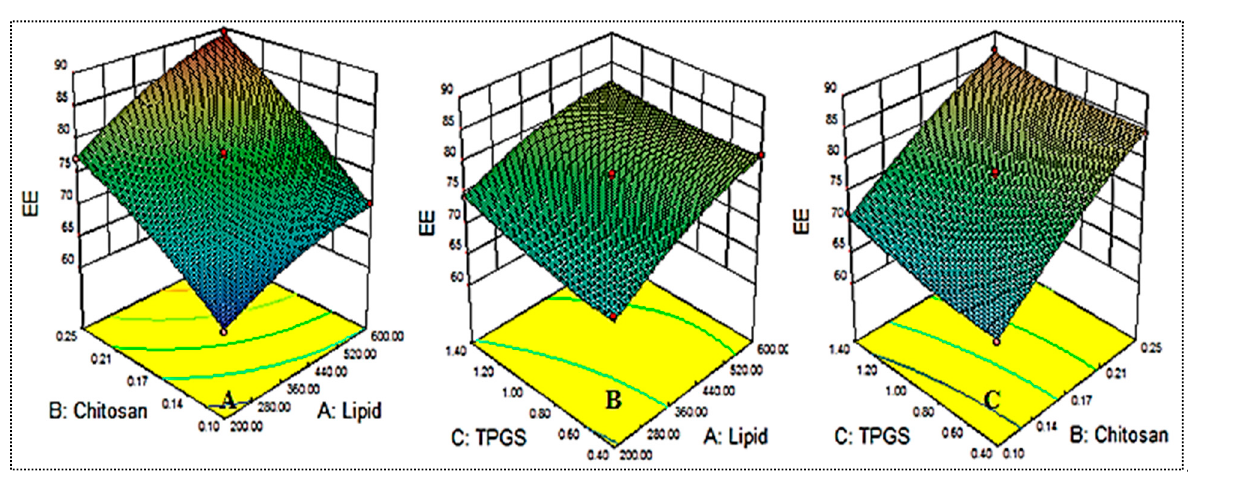
Table 4. Point prediction optimization using the Box–Behnken design.